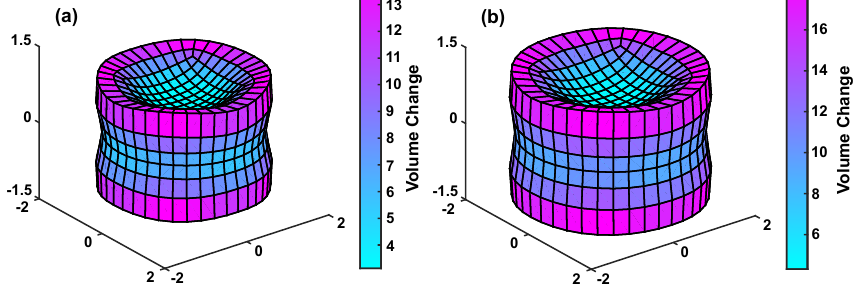
Figure 6. Transient surface instabilities of ( a ) ionic pressure simulation and ( b ) total swelling pressure simulation after 35 s. (Full videos available at http://dx.doi.org/10.17632/95svb4kr2j.1).